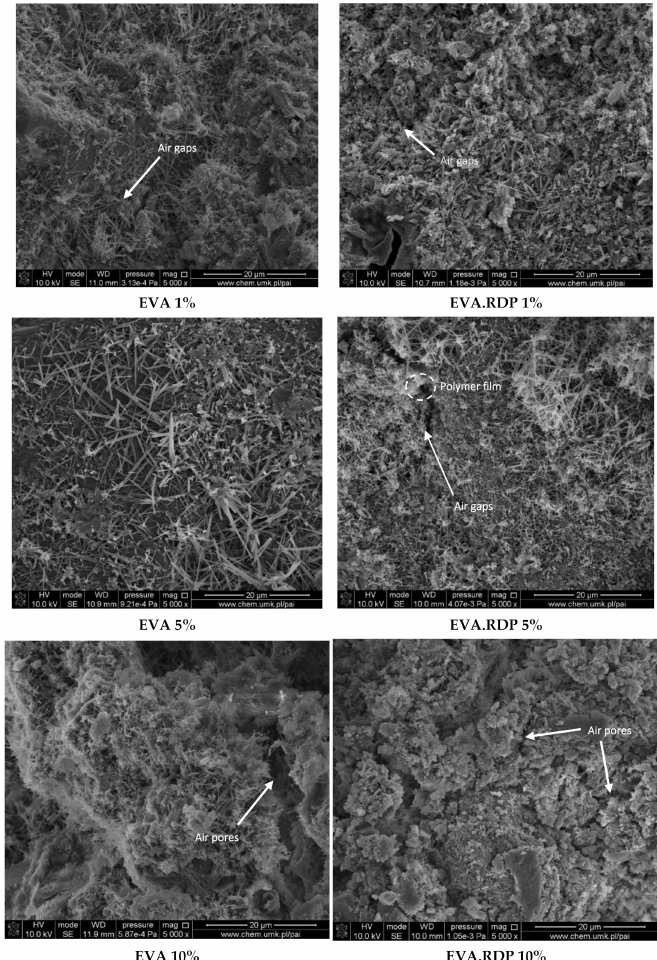
Figure 9. SEM microstructure of concrete with an addition of EVA and EVA.RDP (1%, 5%,